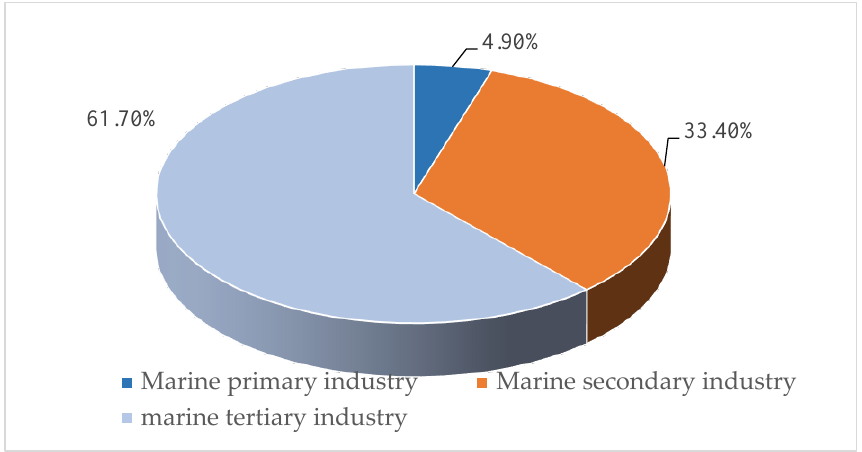
Figure 6. The proportion of the three major marine industries in 2020. Data source: General Administration of Customs of China.